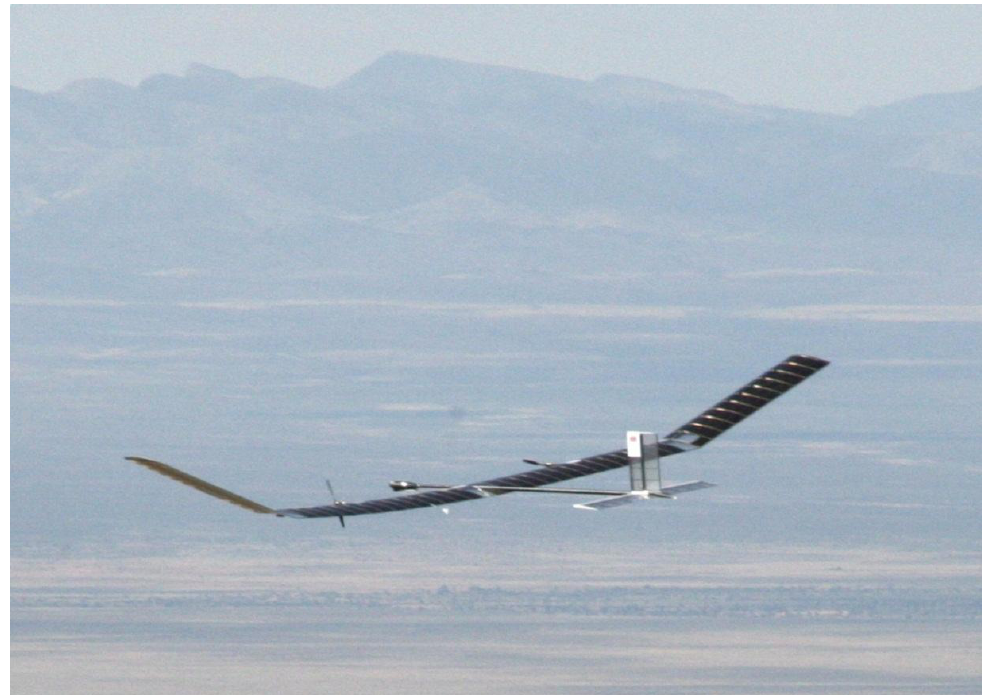
Figure 12. The Qinetiq Zephyr HALE UAS. Image courtesy QuinetiQ Group, PLC, Farnborough, Hampshire,